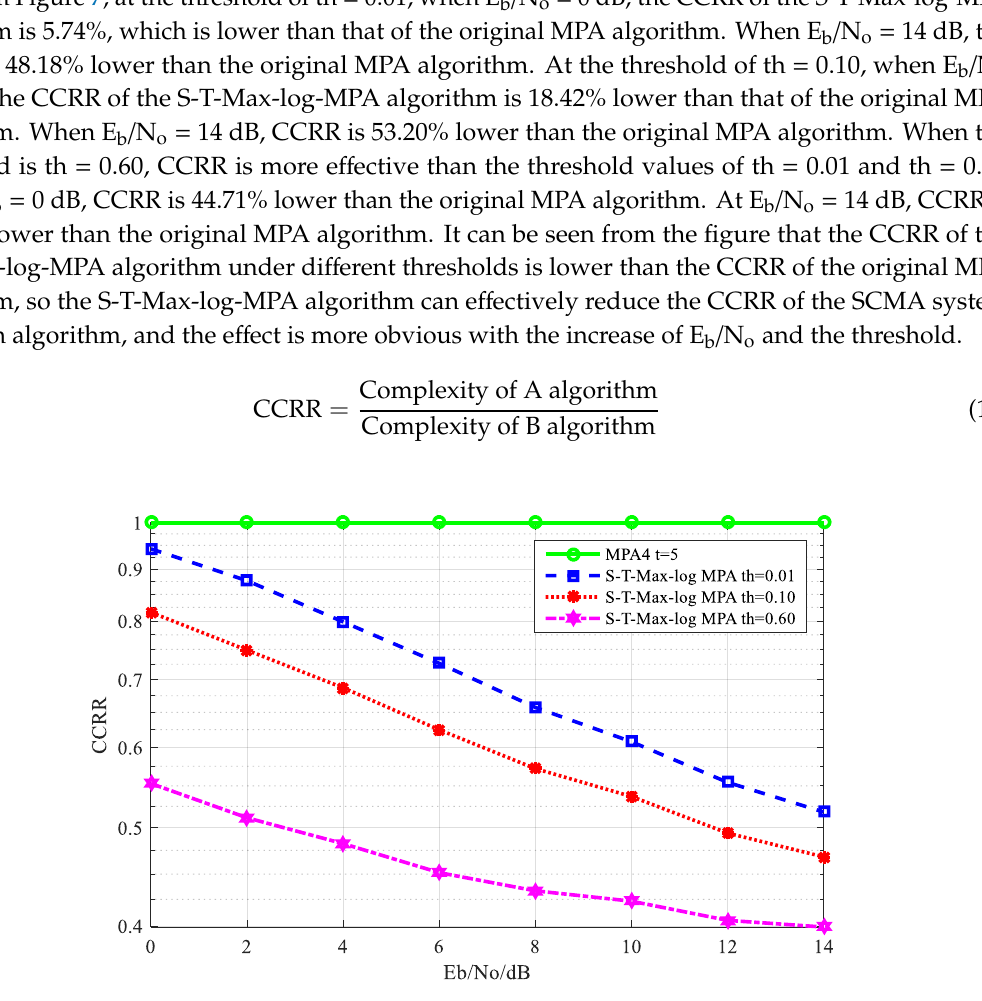
Figure 7. Comparison of the Computational Complexity Reduction Ratio (CCRR) between original Message Passing Algorithm (MPA) algorithm and S-T-Max-log-MPA algorithm, where S-T-Max-log-MPA is Maximum logarithm Message Passing Algorithm based on Serial and